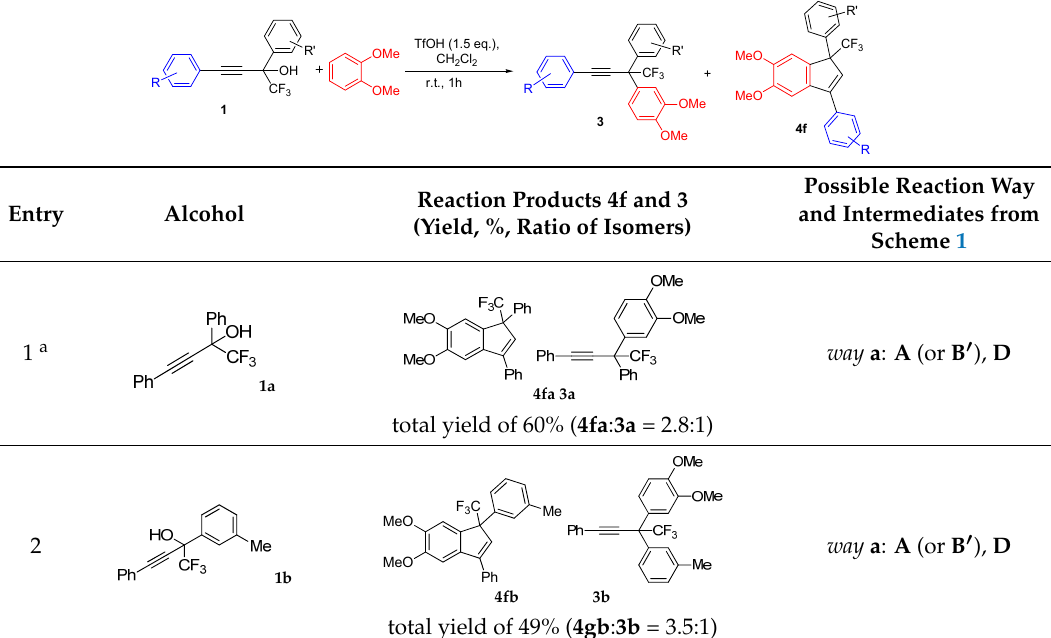
mount of TfOH was 2.5 equiv. Surprisingly, reactions of alcohols 1 with veratrole yieldedmixtures of alkyne 3 and indene 4f . Moreover, treatment of alkyne 3 with TfOH (1.5 eq.) in CH 2 Cl 2 at room temperature for 1 h gave indene 4f . This data unambiguously proves that reactions with veratrole proceed in way a with the participation of cations A (or B ′ ) and D (see Scheme 1). Table 7. TfOH-promoted reaction of 1 with veratrole; reaction conditions: TfOH, CH 2 Cl 2 , molar ratio of 1 :veratrole:TfOH = 1:1.1:1.5, room temperature, 1 h.